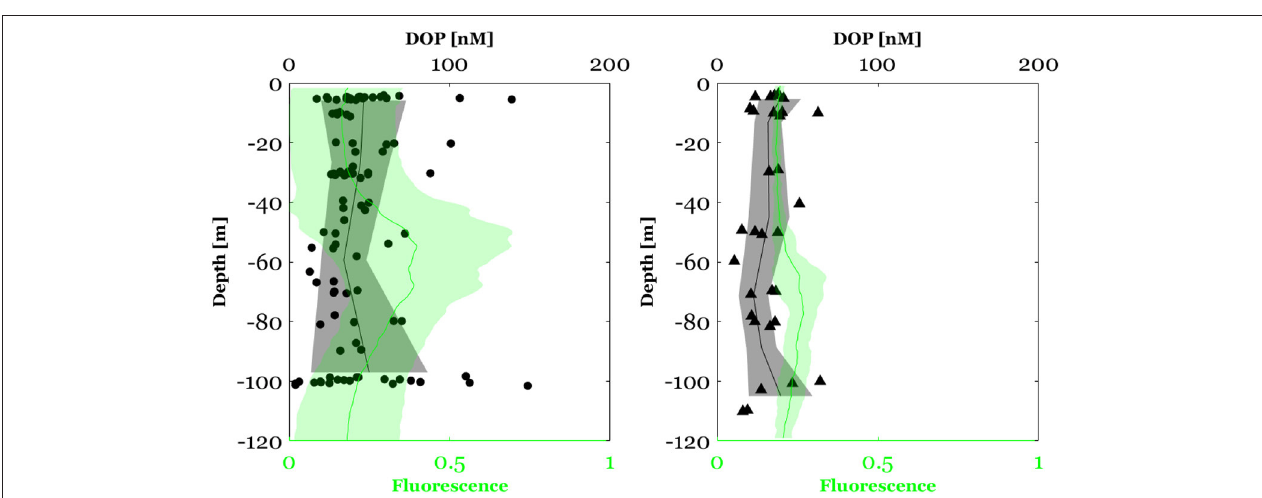
FIGURE 6 | Dissolved organic phosphate (DOP) concentration in the North Western Mediterranean Sea (circles) and Along the E-W transect crossing Ionian and Tyrrhenian seas (triangles). The black plot represents the mean depth profile of DOP concentrations and the bounded line the deviation from the mean. The green plot represents the fluorescence profile (mean ± standard of deviation).